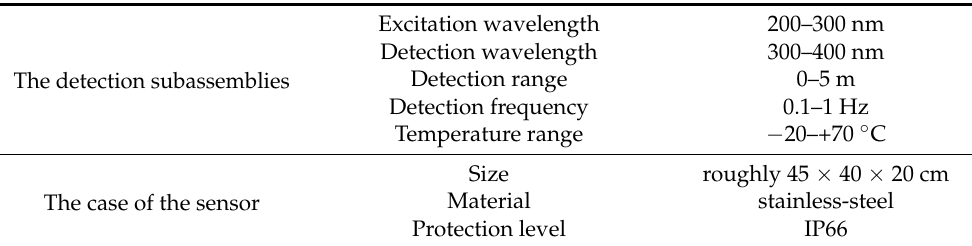
Table 1. The main parameters of the coastal-mounted sensor.